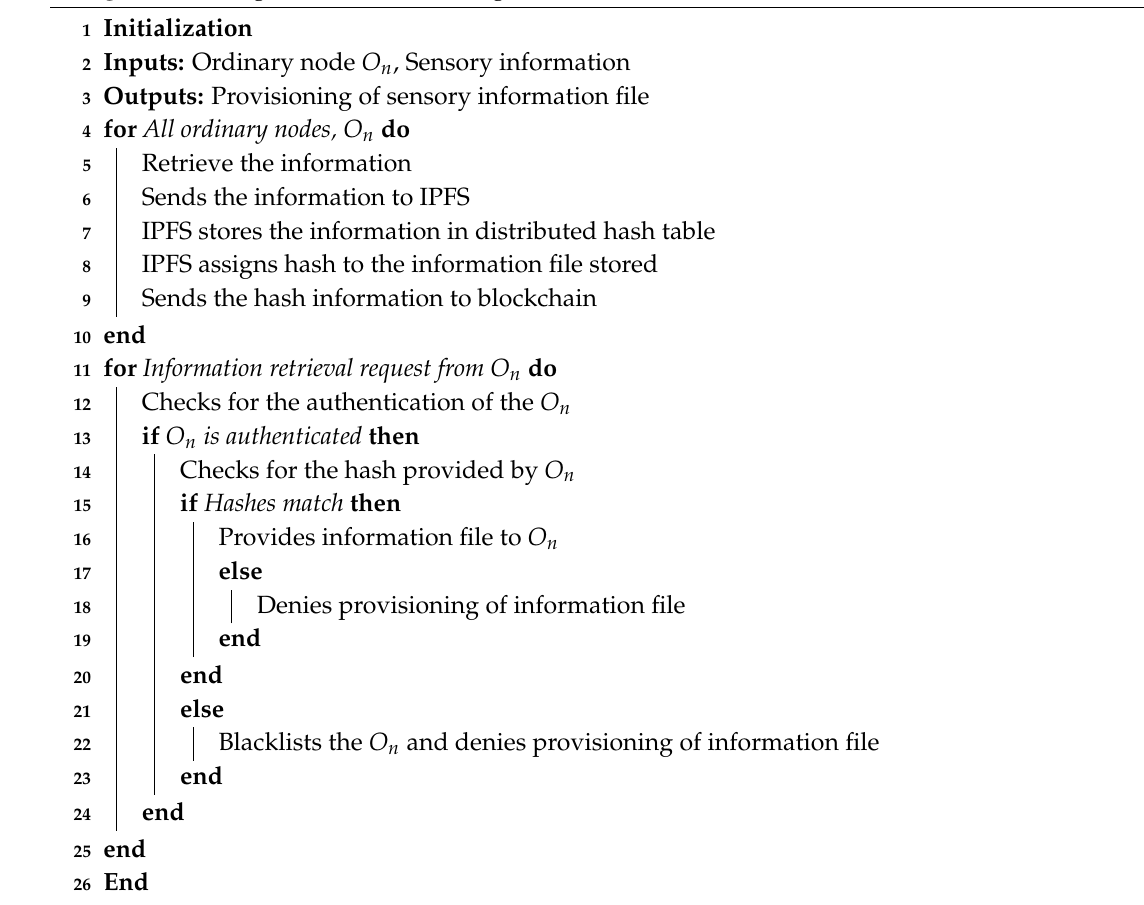
Algorithm 2: Algorithm of Data Storage in